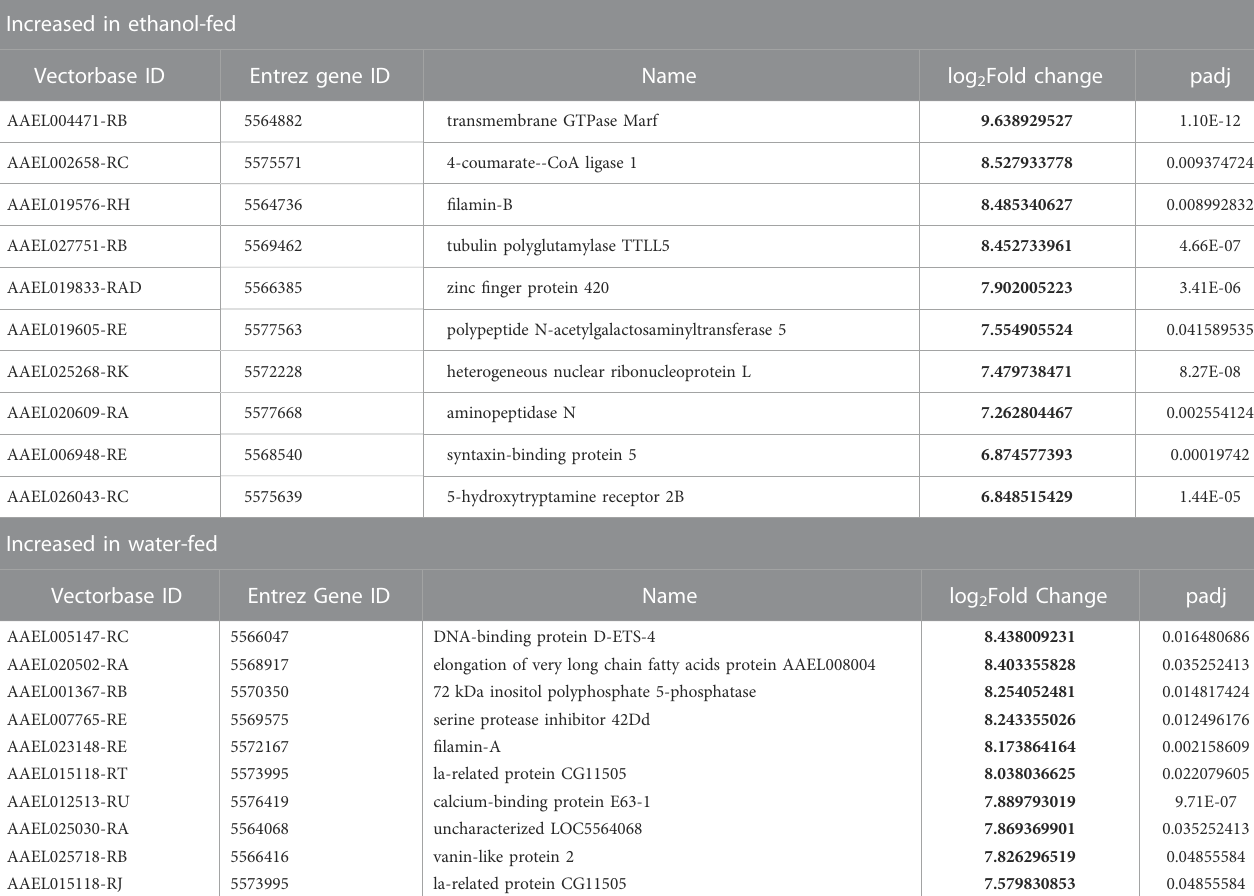
TABLE 1 Top ten genes with signi fi cantly different gene expression between ethanol-fed and water-fed non-irradiated male Ae. aegypti . Increased in ethanol-fed